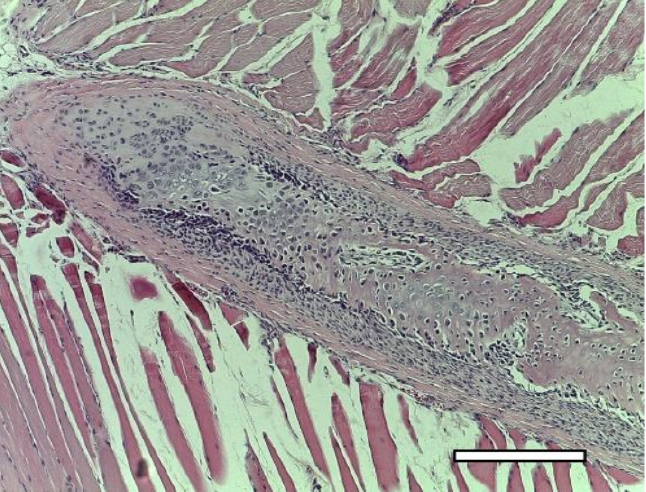
Figure 19. 3rd group (dECM and MSC), 1 week. Cartilage cells with signs of indirect osteogenesis in the muscle tissue near the scaffold. Staining with hematoxylin and eosin. Objective lens × 2.5, scale bar—800 µ